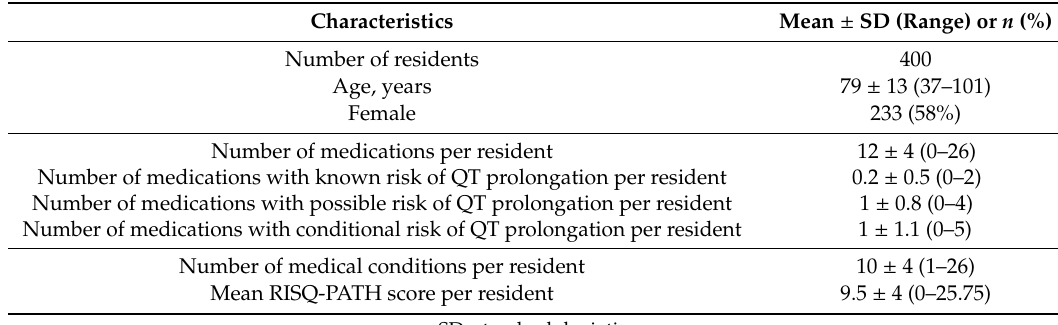
Table 2. Patient